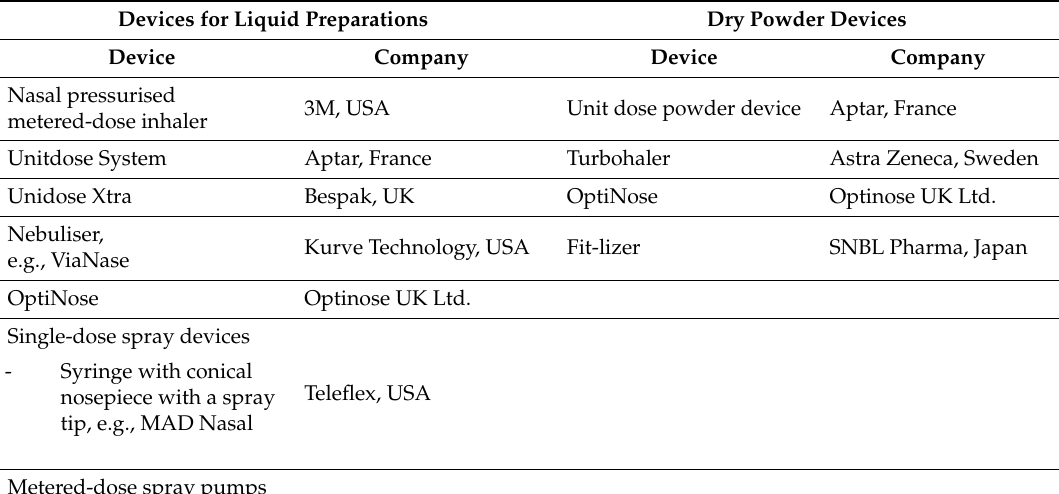
Table 5. Examples of devices for nasal